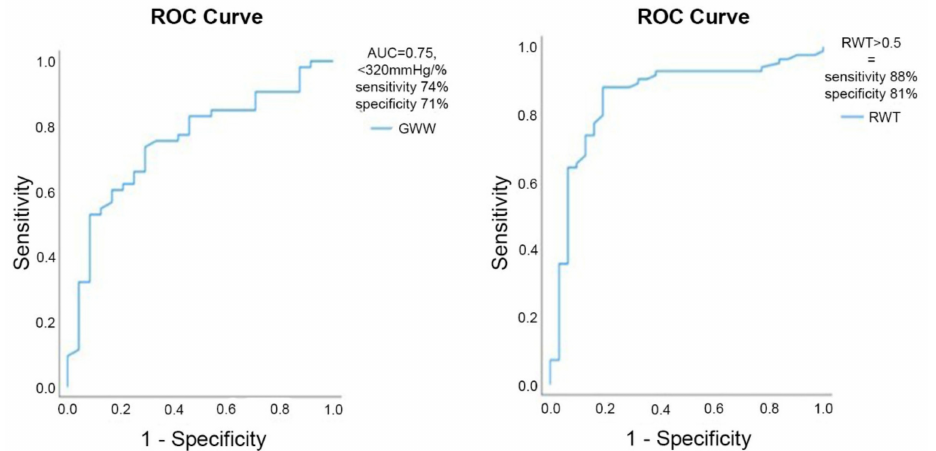
Figure 2. Left curve: ROC analysis from GWW (AUC = 0.75) identifying ATTR-CA and right curve: RWT (AUC = 0.84) identifying